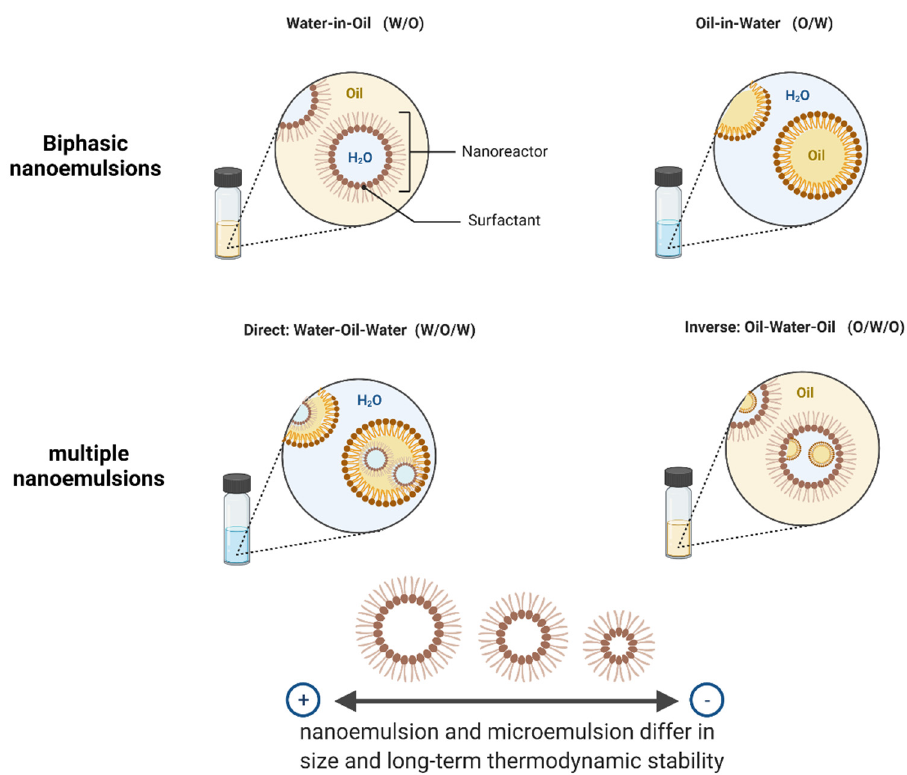
Figure 3. Classification of nanoemulsions.